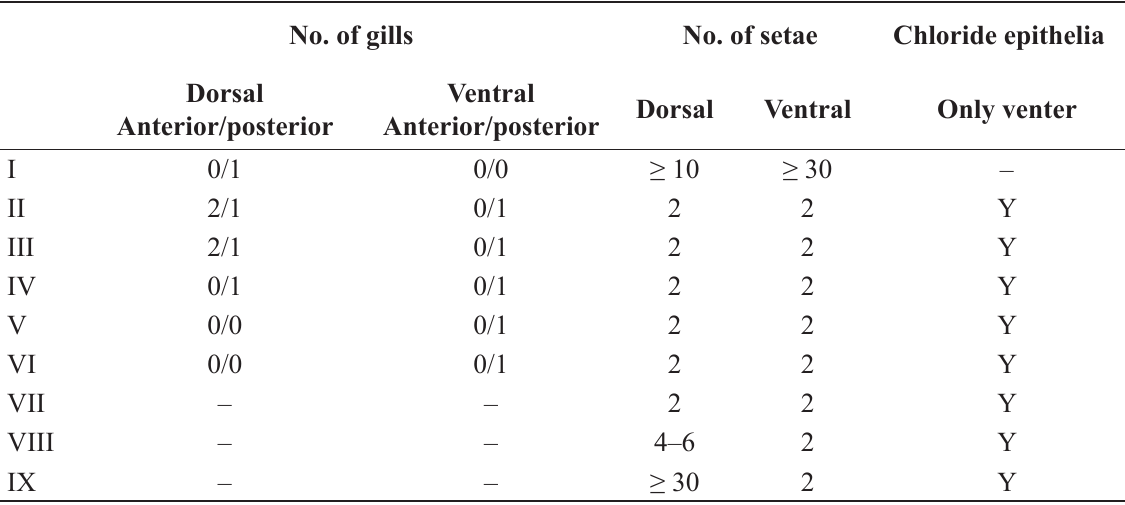
Table 3. Number of single tracheal gills, setae and chloride epithelia on abdominal segments I–IX (Y: character present; –: character